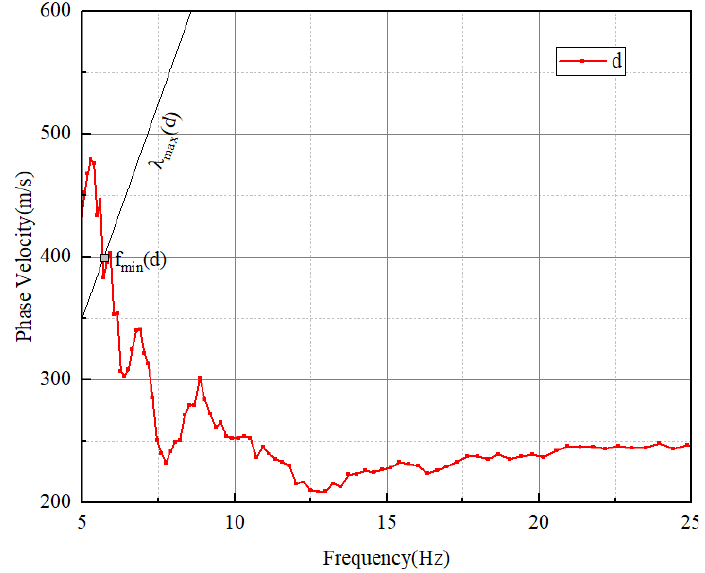
Figure 4. Principle of maximum reliable low-frequency calculation.